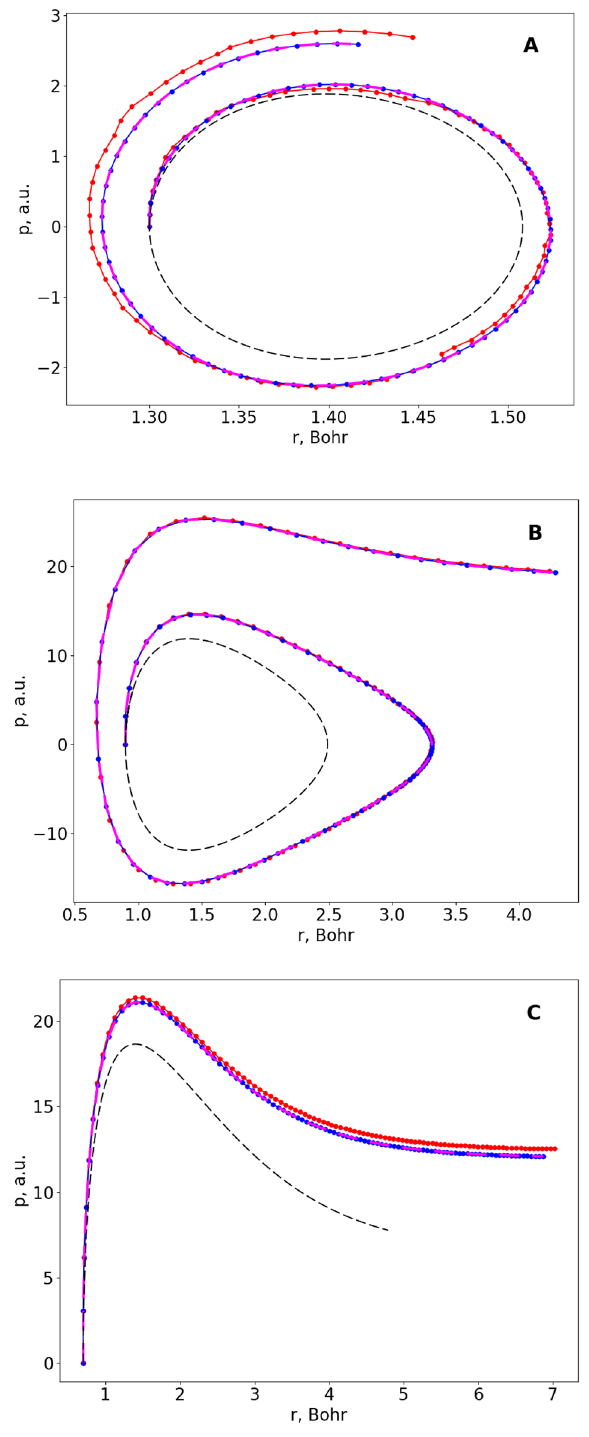
Figure 3. Different types of trajectories for the vibration of the H 2 molecule. All trajectories are plotted in the phase space (momentum vs coordinate): ( A ) in the low-energy regime of nearly harmonic motion, ( B ) in the high-energy regime of strongly anharmonic motion, and ( C ) at an energy above the dissociation threshold that leads to bond breaking. The exact analytical solution (dashed black), a classical QP solution (dashed magenta) and solutions obtained using the D-Wave quantum annealer with (blue) and without (red) greedy postprocessing are presented for each